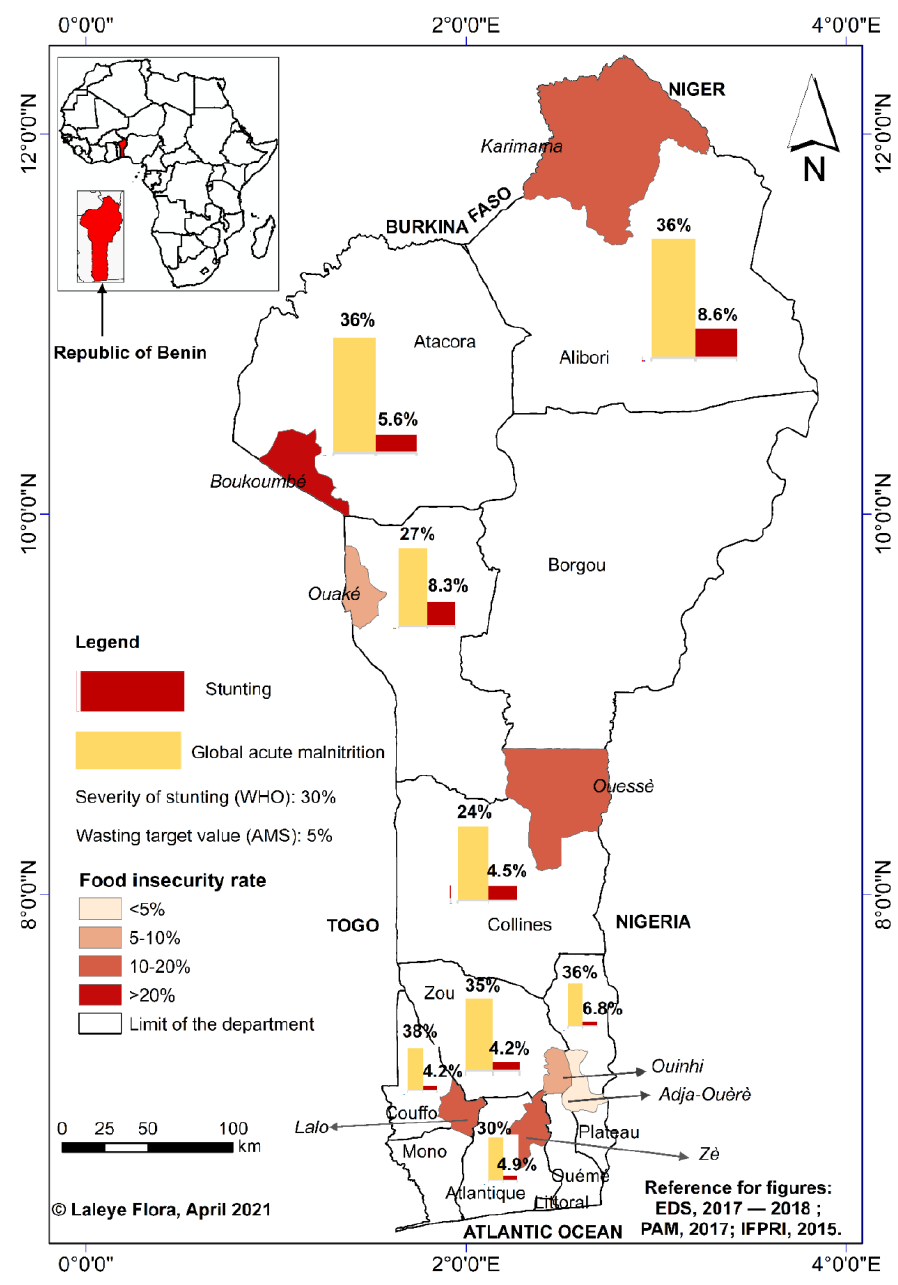
Figure 1. Study areas.